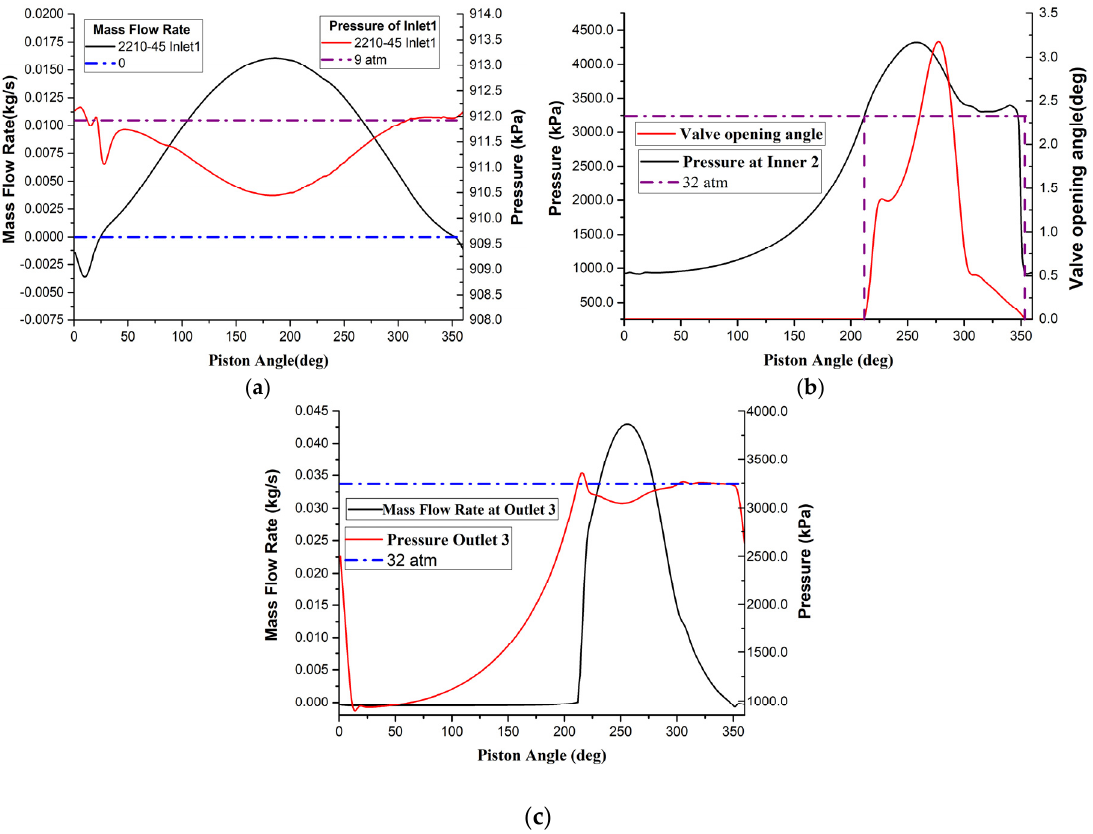
Figure 7. Physical properties of basic type, model 2210-45: ( a ) mass flow rate and pressure at Inlet 1, ( b ) pressure of compression chamber at Inner 2 and opening angle of reed valve, ( c ) discharge mass flow rate and pressure at Outlet 3.